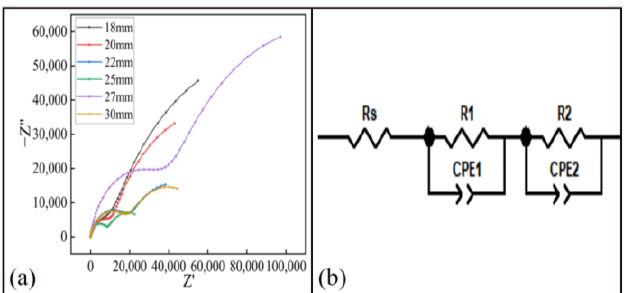
Figure 17. Electrochemical test results of the coating at different spraying distances: ( a ) Nyquist diagram, ( b ) equivalent circuit model diagram. Table 5. EIS fitting results of Al – Zn composite coating at different spraying distances at the initial immersion stage in 3.5 wt % NaCl solution.